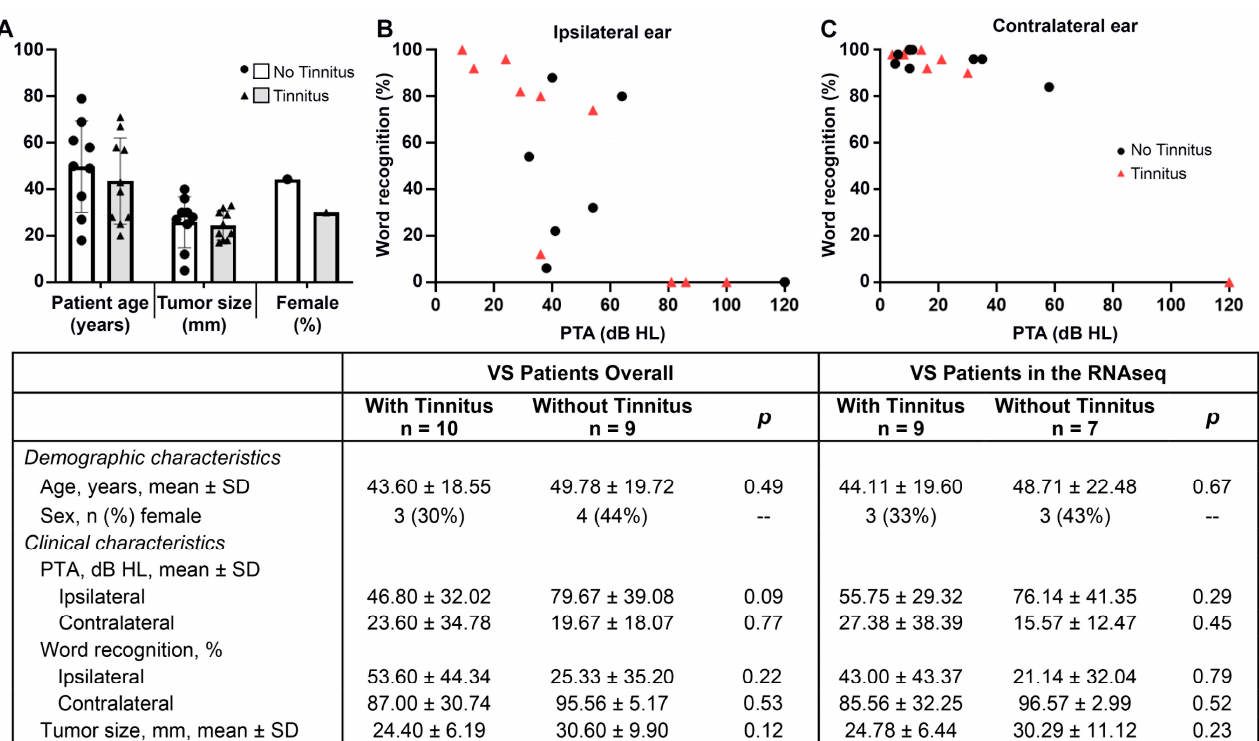
Figure 2. Demographic and clinical characteristics of VS tissue donors with and without tinnitus. The distribution of patient age, sex, and tumor size are shown in ( A ), while patients’ pre-surgical PTA ipsilateral and contralateral to the tumor are in ( B , C ), respectively. The clinical and demographic characteristics were not significantly different between the included patients with tinnitus (triangles, gray bars) or without tinnitus (black dots, white bars) overall or among patients included in the RNA sequencing. Word recognition, PTA, and presurgical tumor size (measured in transverse dimension in the cerebellopontine angle via magnetic resonance imaging) were collected from the most recent test/scan prior to VS tumor resection. Abbreviations: dB, decibel; HL, hearing level; PTA, pure tone average; SD, standard deviation.